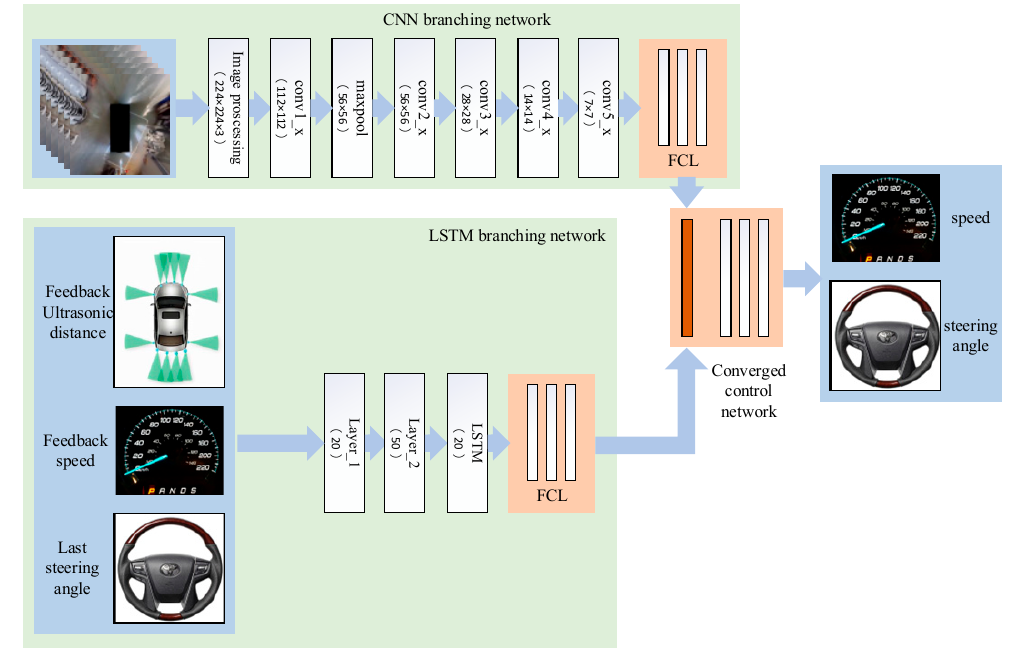
Figure 1. The architecture of CNN-LSTM intelligent parking